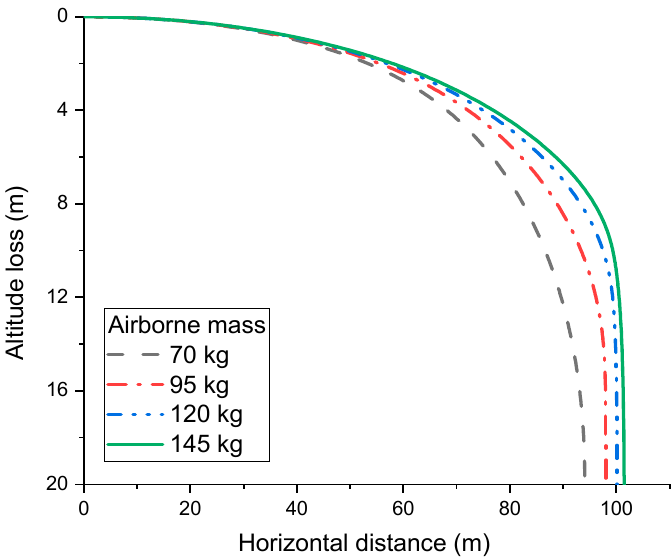
Figure 9. Velocity changes of parachute systems with different masses.